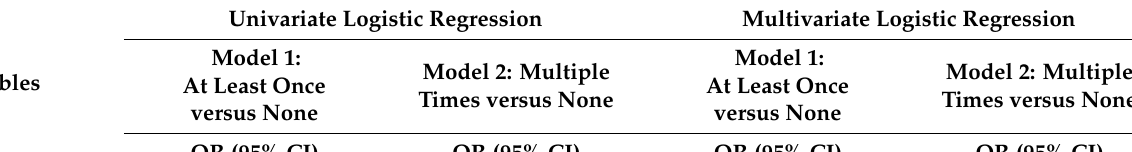
Table 3. Models of participation in fights among school-age children in Serbia,